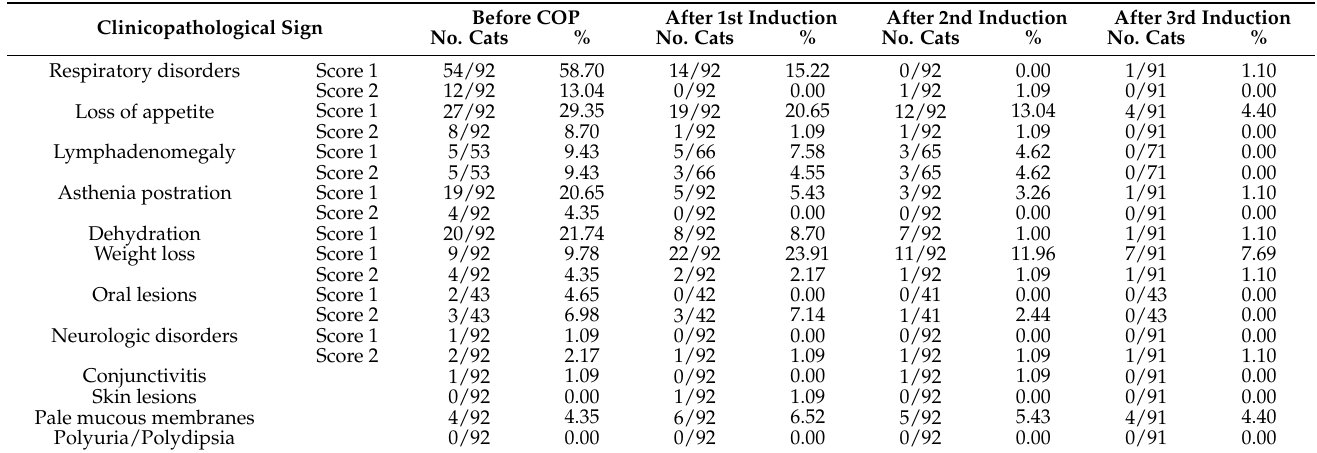
Table 2. Clinical signs of feline lymphoma on day of diagnosis, after 1st, 2nd, and 3rd induction of COP chemotherapy.